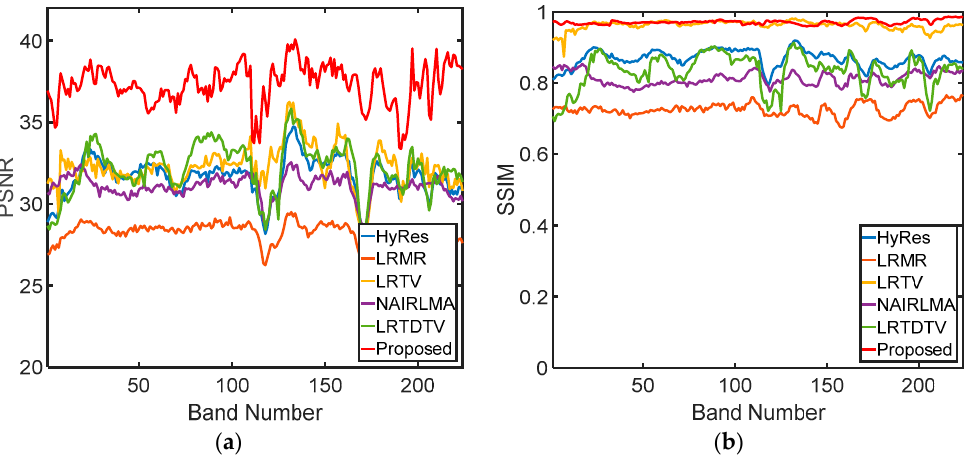
Figure 5. The peak signal-to-noise ratio (PSNR) value ( a ) and structural similarity index (SSIM) value ( b ) of each band when the noise variance is 60.